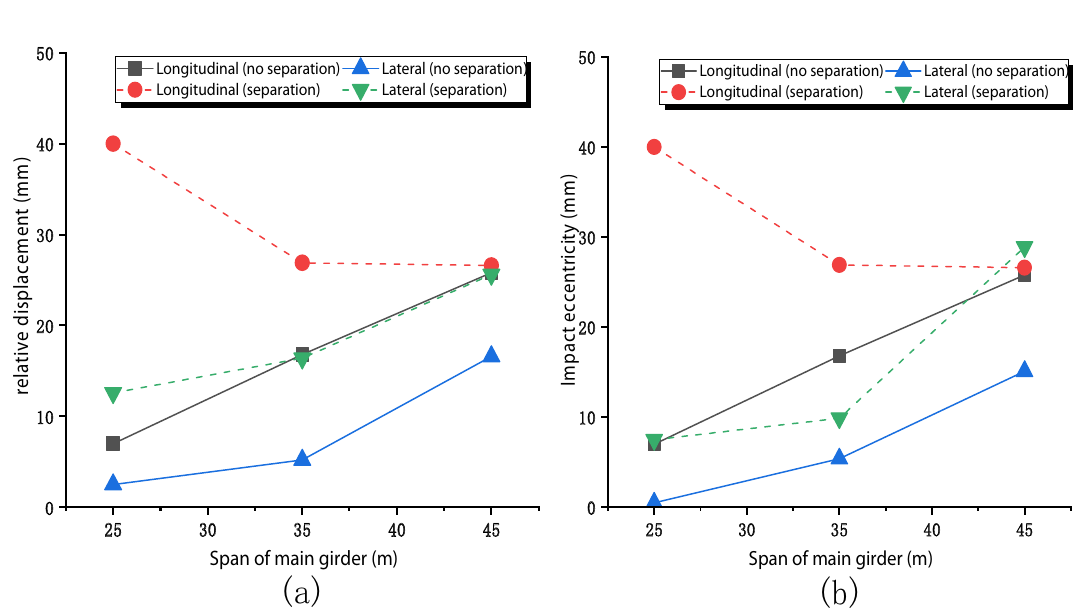
Figure 11. Influence of separation on the bridge under different main girder span: ( a ) Relative displacement; ( b ) Impact and the spring stiffness is the shear stiffness of the support. The bearing is bonded with the pier and overlapped with the main beam. To simulate the pier-beam separation condition caused by near-fault vertical earthquake excitation, when the vertical relative displacement of the middle of the main beam and the top of the pier is greater than the sup- port height ∆Z and shows an increasing trend, it means that the main beam and the pier are separated in the vertical direction. The longitudinal spring element is set as a dead element, and the main beam and the pier are not connected in the vertical direction. When the vertical relative displacement between the middle of the main beam and the top of the pier is less than the support height ∆Z and shows a decreasing trend, the main beam, and the pier collide vertically, the longitudinal spring element is a live element, and the main beam and the pier are connected. See Fig. 12 for a specific calculation. The main beam and pier are separated when the seismic excitation period T = 0.25 s and the vertical seismic peak acceleration is 0.6 g. Figure 13 shows the axial pressure of the pier under the finite element solution and theoretical solution. Under the theoretical solution, the maximum axial pressure on the pier is 16.8 MN, 2.8 times the static pressure. Under the finite element solution, the maximum axial pressure on the pier is 22.13 MN, 3.67